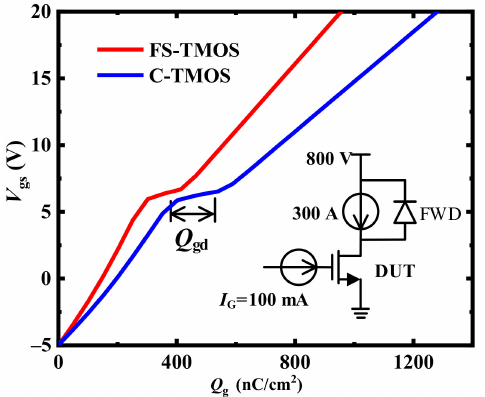
Figure 7. Gate a charge of optimum FS- and